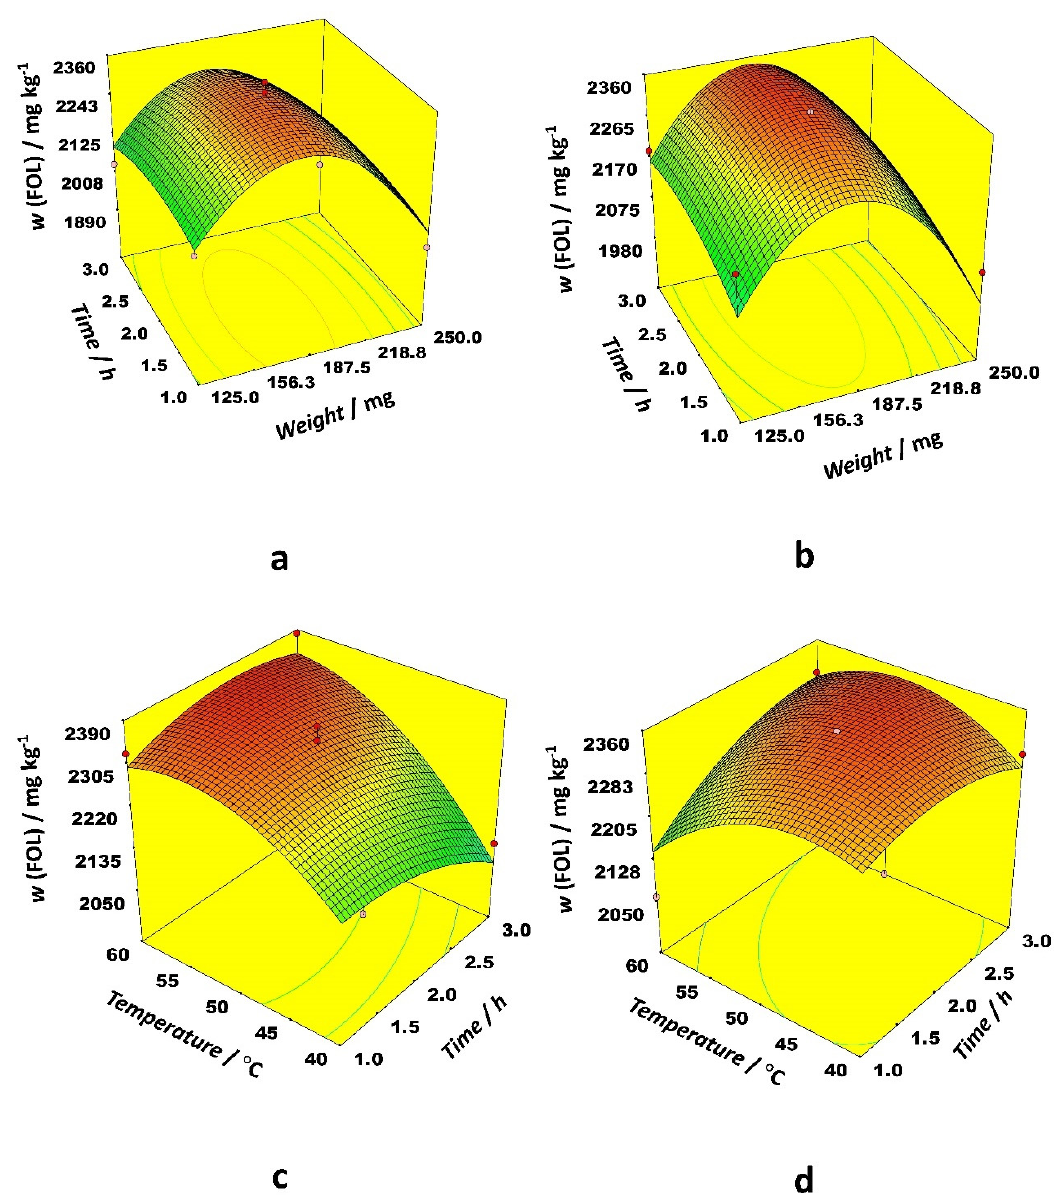
Figure 2. 3D response surface plots of the most prominent interaction factors for flavan-3-ols extracted from grapevine leaves using ethanol (subfigures a , c ) and acetonitrile (subfigures b , d ) as organic modifiers.